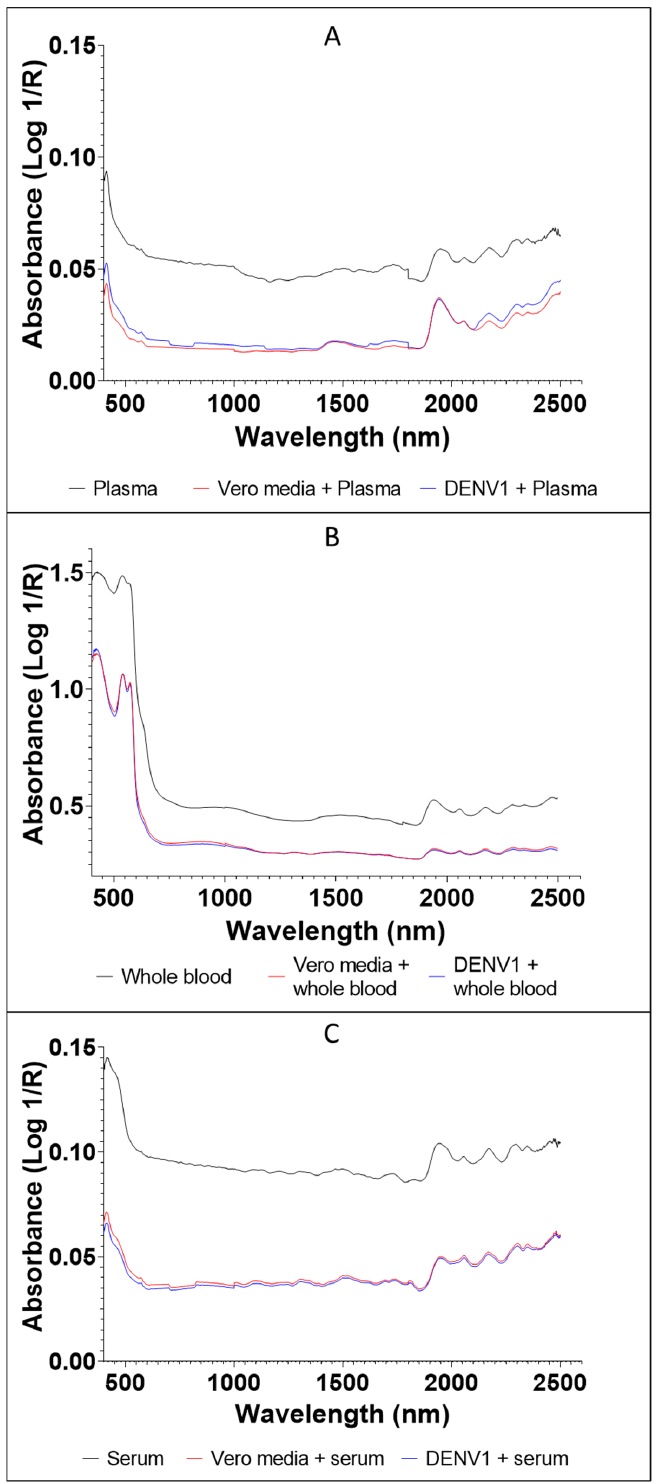
Figure 2. Average NIR unprocessed spectra of plasma ( A ), whole blood ( B ), and serum ( C ) alone, combined with Vero media or DENV1. Spectra of all concentrations/donor tested were averaged into a single spectrum for all samples. In total, 1100, 600 and 760 NIR spectra for plasma, whole blood, and serum samples, respectively, were